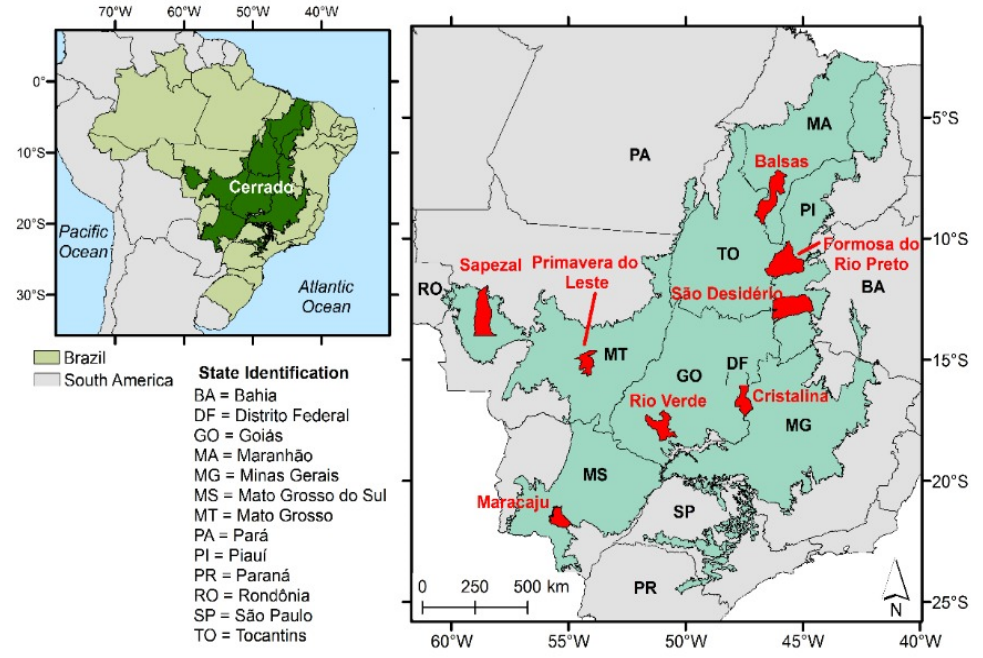
Figure 3. Eight selected municipalities in the Cerrado biome with the highest grain production.